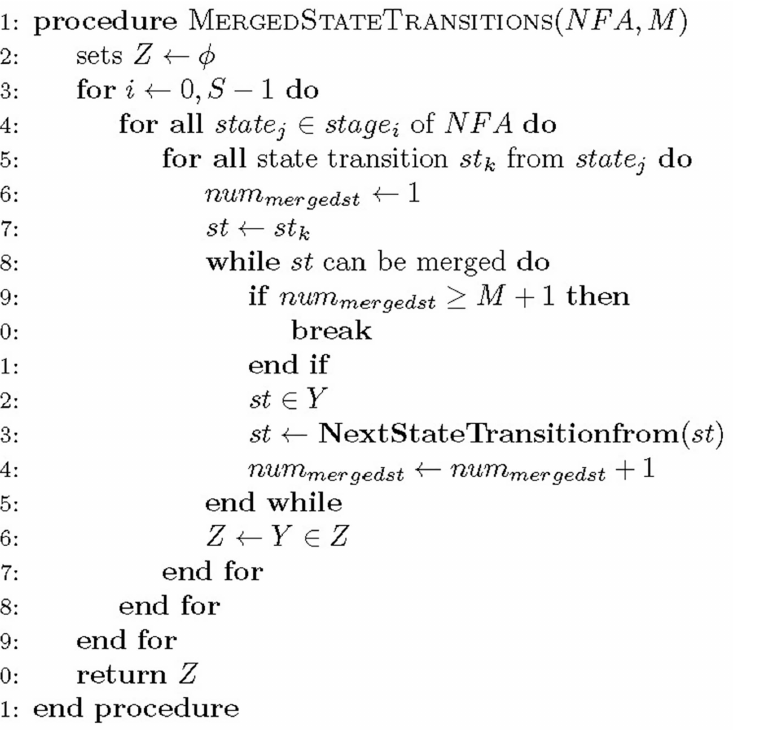
Fig 3. Pseudo code for extracting sets of state transitions to be